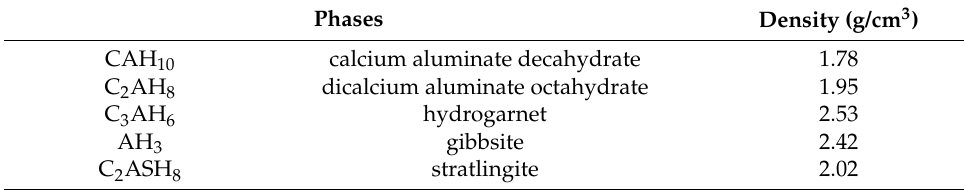
No 5% Glass Additive